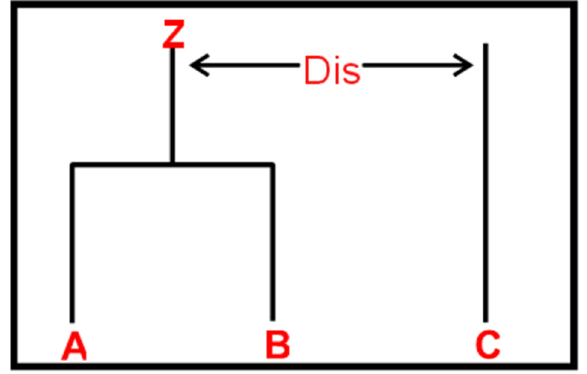
Figure 3. Diagram of Cluster Z.